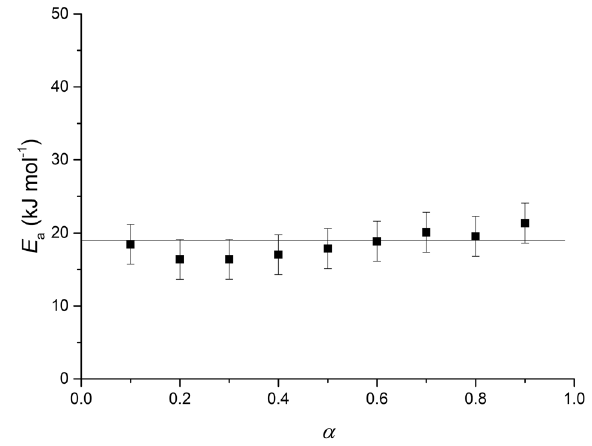
Figure 4: The changes of dC/dt on degree of caffeine extraction.